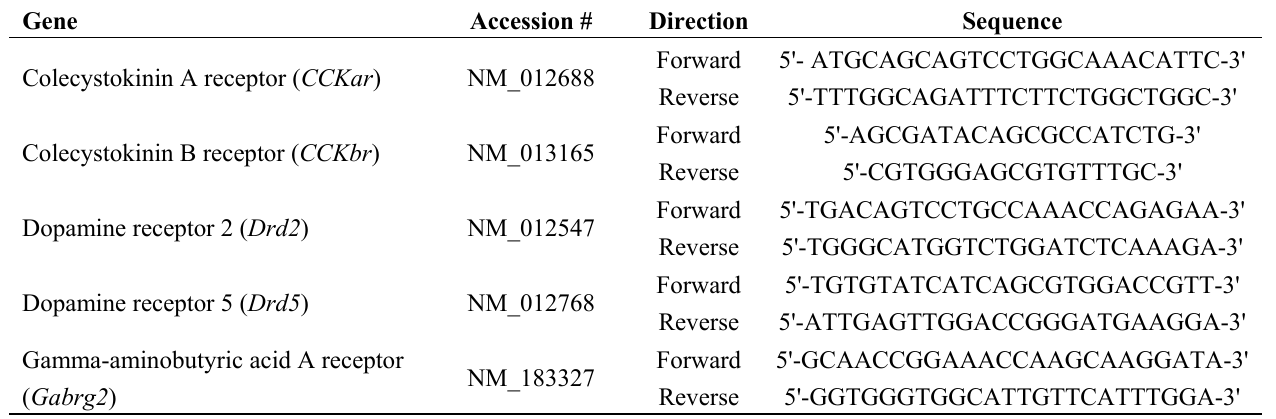
Table 2. Oligonucleotide sequences for primers used in the RT-PCR